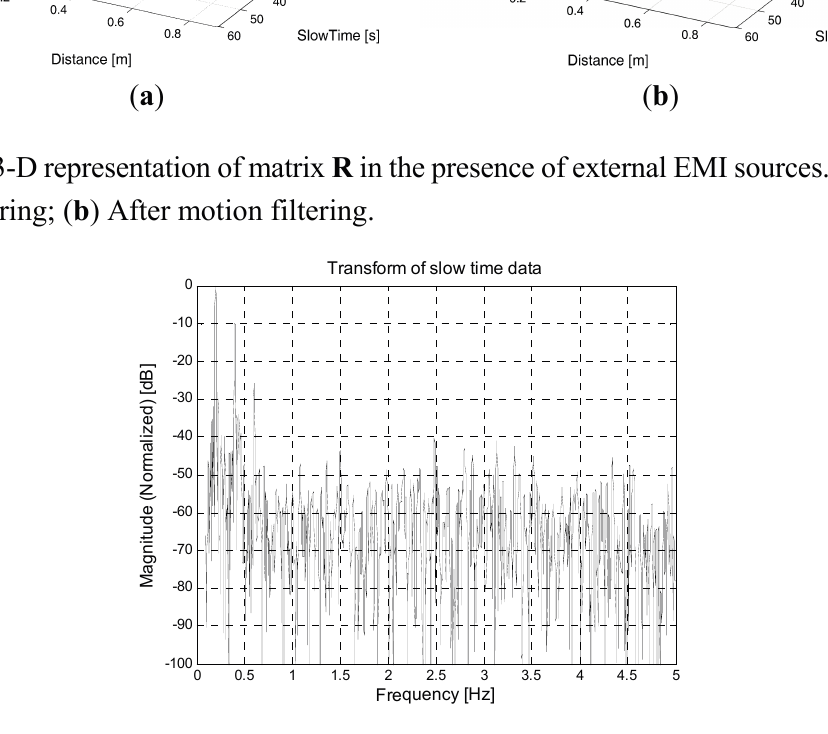
Figure 26. Spectral analysis in the presence of external EMI